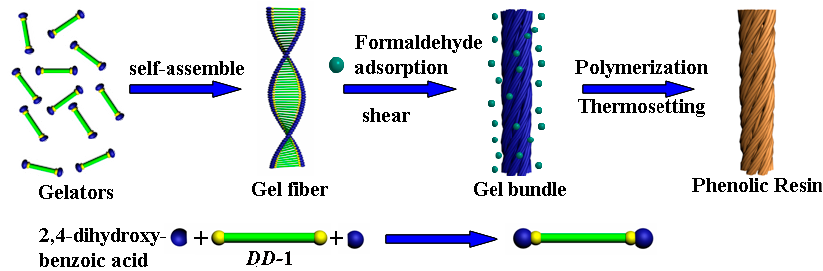
Figure 5. Schematic illustration of the formation of helical phenolic resin bundles.